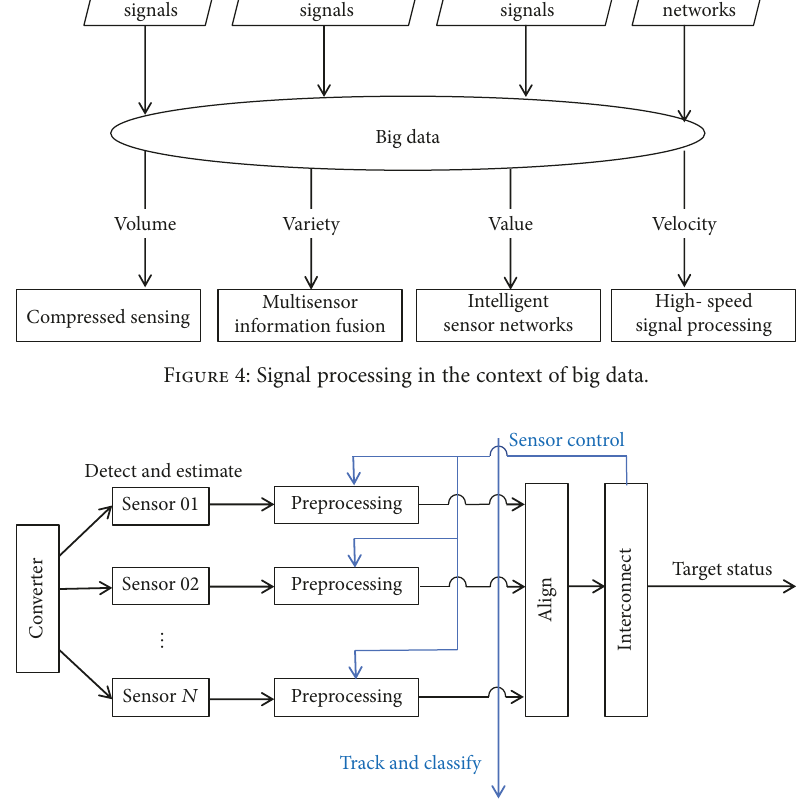
Figure 5: Centralized fusion system architecture.